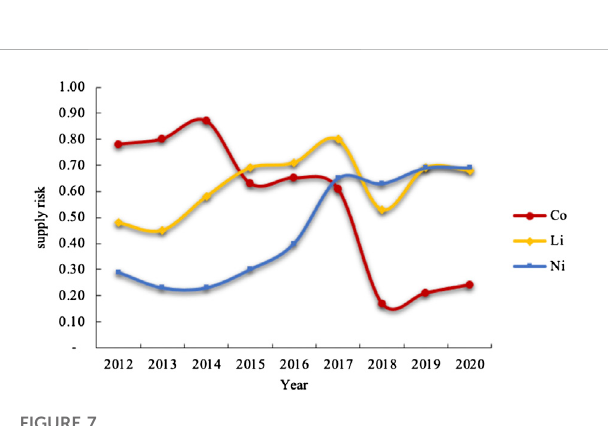
FIGURE 7 China ’ s imported lithium, cobalt, and nickel minerals supply risk